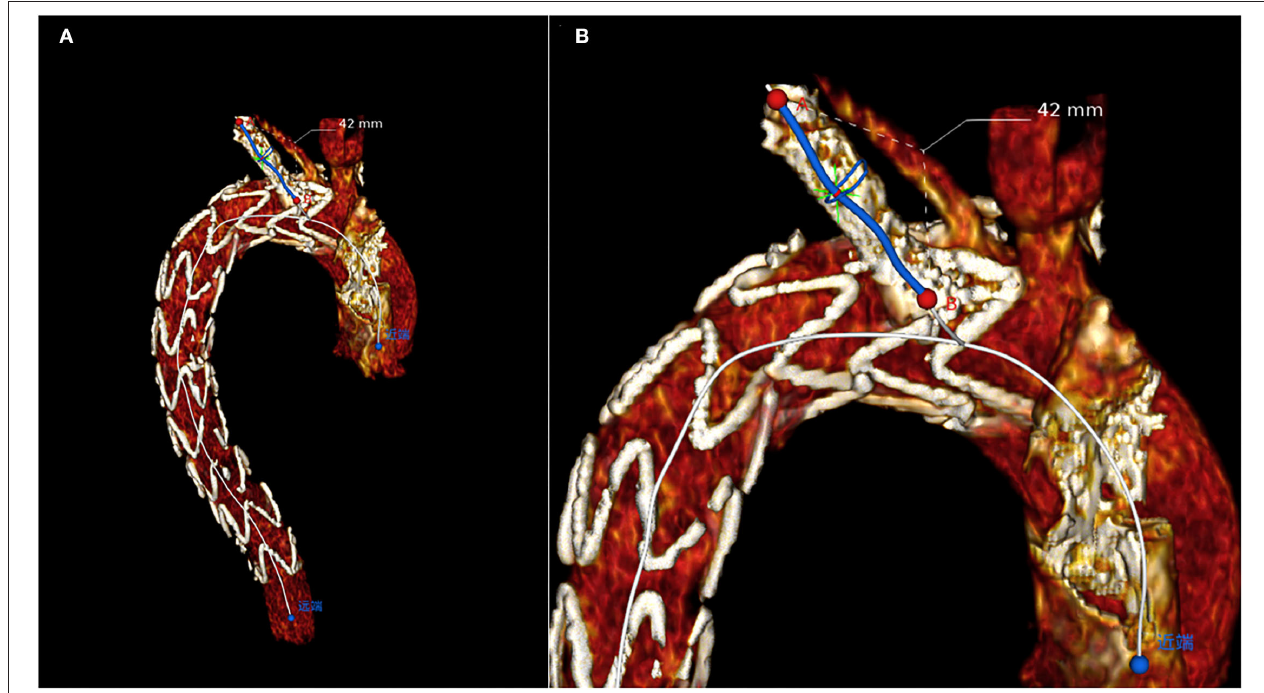
FIGURE 2 | Plane of CTA image adjustment principle: Adjust the CTA image plane from all directions until the observer’s line of sight is perpendicular to the LSA plane. (A) The overall view. (B) The magnified partial